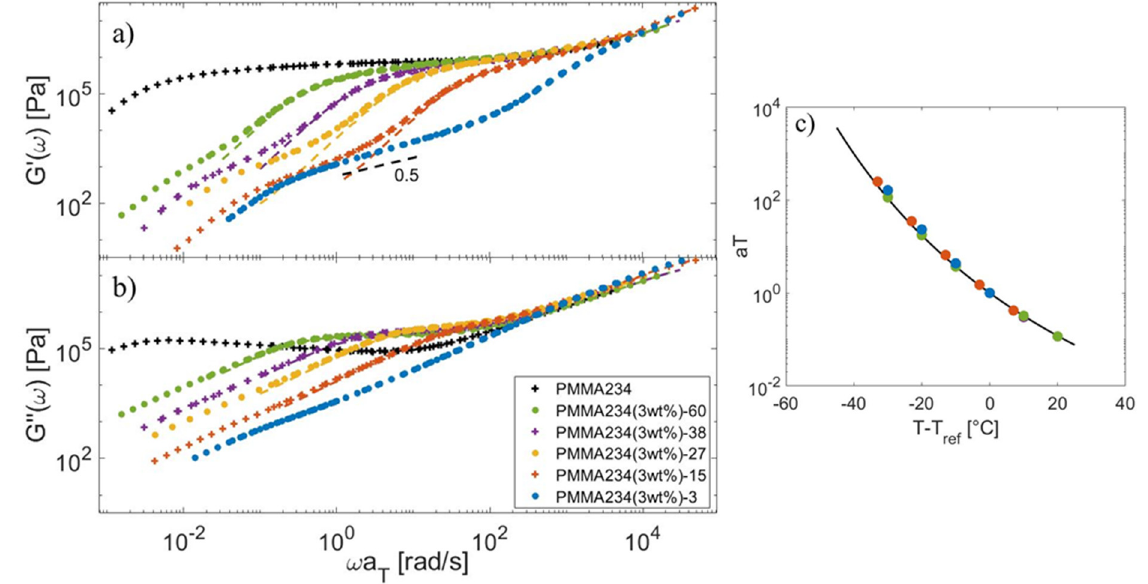
Figure 2. Storage ( a ) and loss ( b ) moduli under iso- T g condition of the PMMA234-Matrix blends (symbols) and of the short component in the monodisperse state (dashed lines), and ( c ) the corresponding shift factors at T ref = T g + 60 ◦ C, compared to the WLF Equation (black